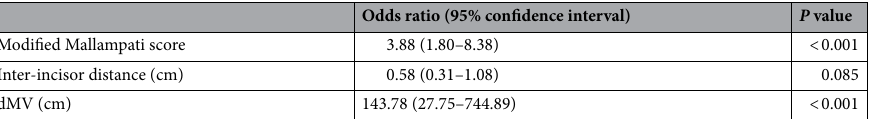
Table 3. Results of logistic regression analysis to predict difficult laryngoscopy, adjusted for sex. dMV (membrane-to-vallecula distance), distance from the midpoint of the thyrohyoid membrane between the hyoid bone and laryngeal prominence to the closest concave point of the vallecula.